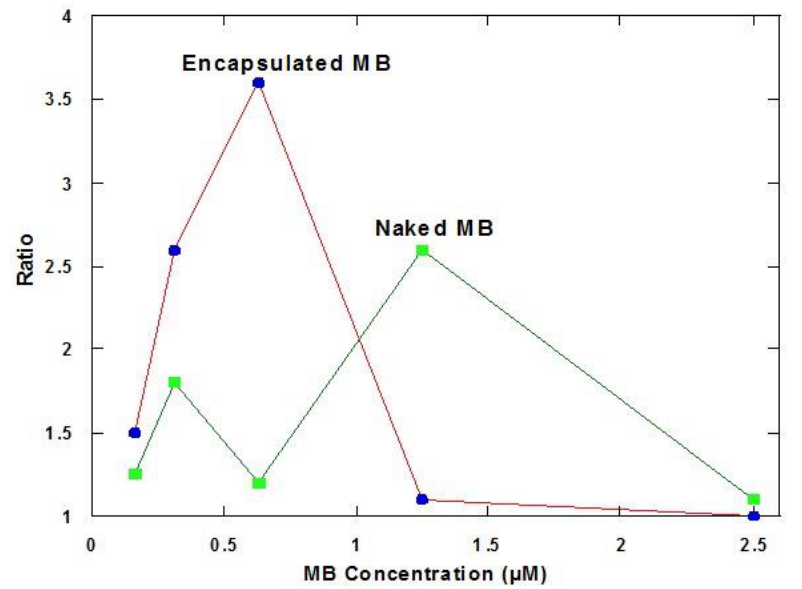
Figure 4. Cytotoxicity of bare and encapsulated MB on osteosarcoma cells at different concentra- tions.